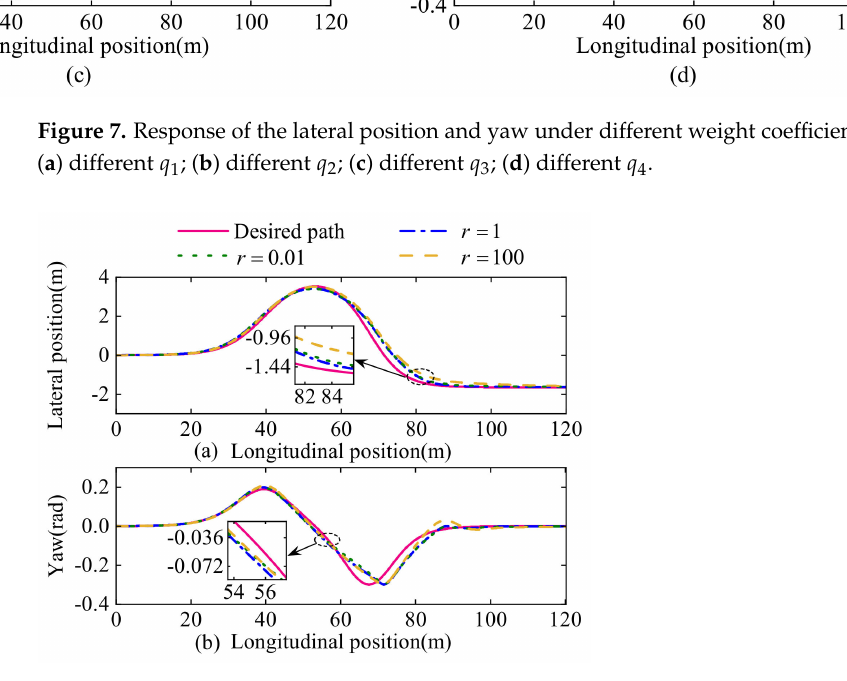
Figure 8. Response of the lateral position and yaw under different weight coefficients of r : ( a ) lateral position; ( b )